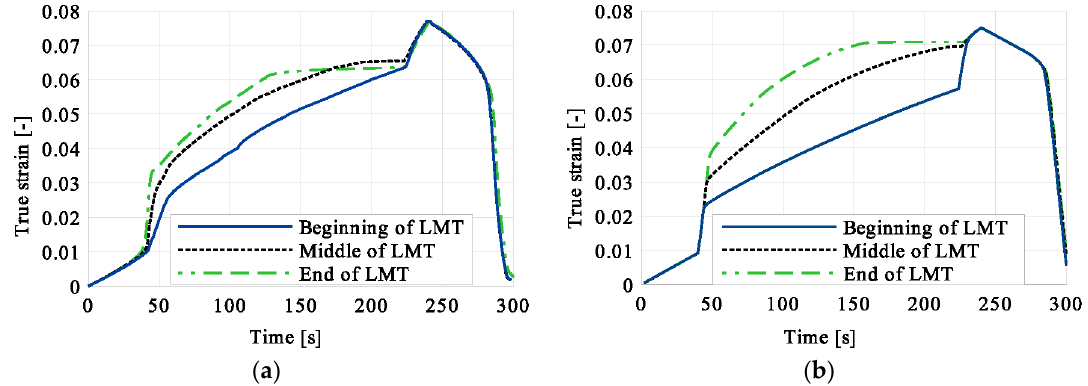
Figure 19. Strain vs. time comparison of experimental and numerical results for the loading program (3): 3-min loading interruption at the beginning of LMT: ( a ) experimental; ( b ) numerical results